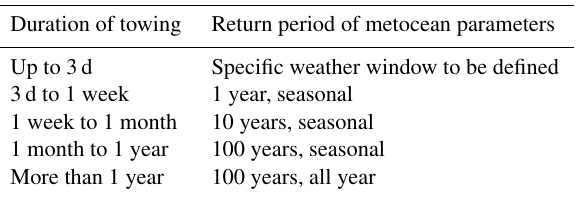
Table 2. Acceptable return period for unrestricted operations (Berg, 2017; DNV,